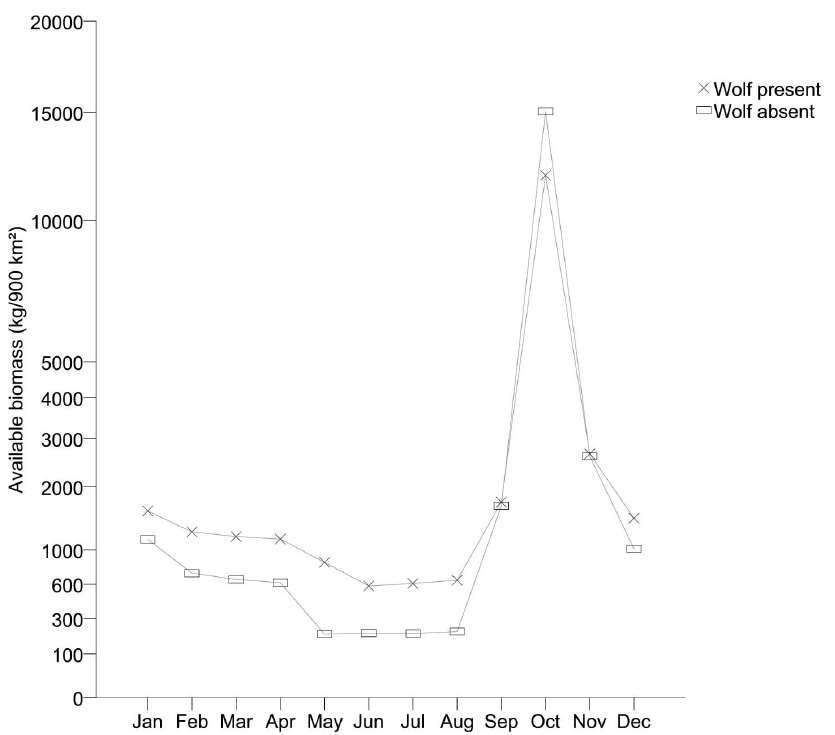
Figure 2. Estimated amount of biomass available for scavenging species in areas with and without wolves. Estimations of available biomass include wolf kills (only for areas with wolves present), hunter harvest, vehicle collisions, and natural death. Calculations are conducted for areas of 900 km 2 corresponding to an average wolf territory in Scandinavia.